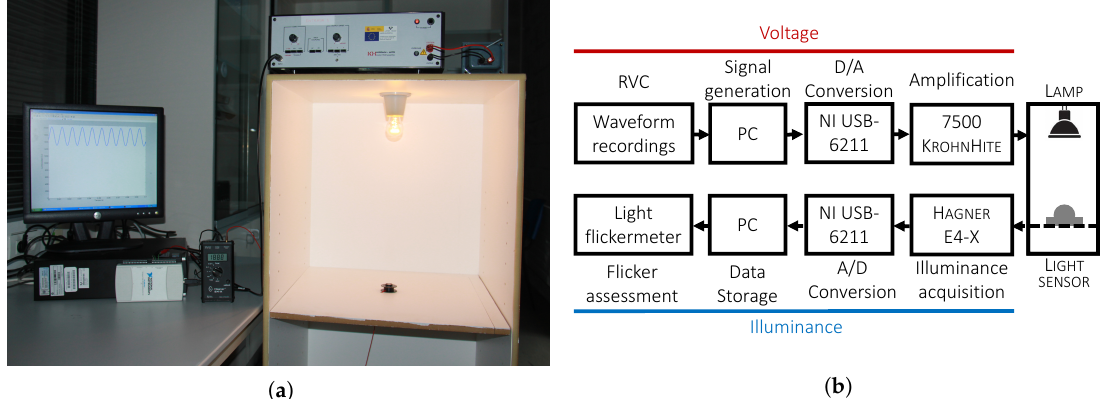
Figure 2. Photograph ( a ) and block diagram ( b ) of the experimental setup.